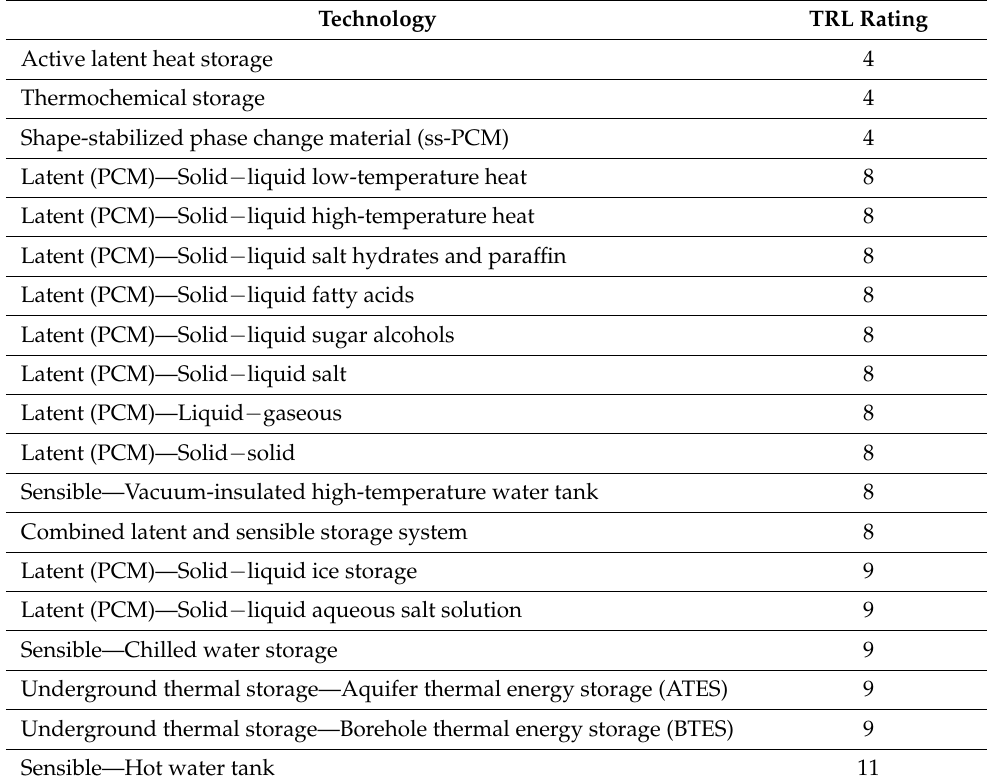
Table 6. TRL rating of thermal storage technologies in building’s heating and cooling sectors [54]. Technology TRL Rating Active latent heat